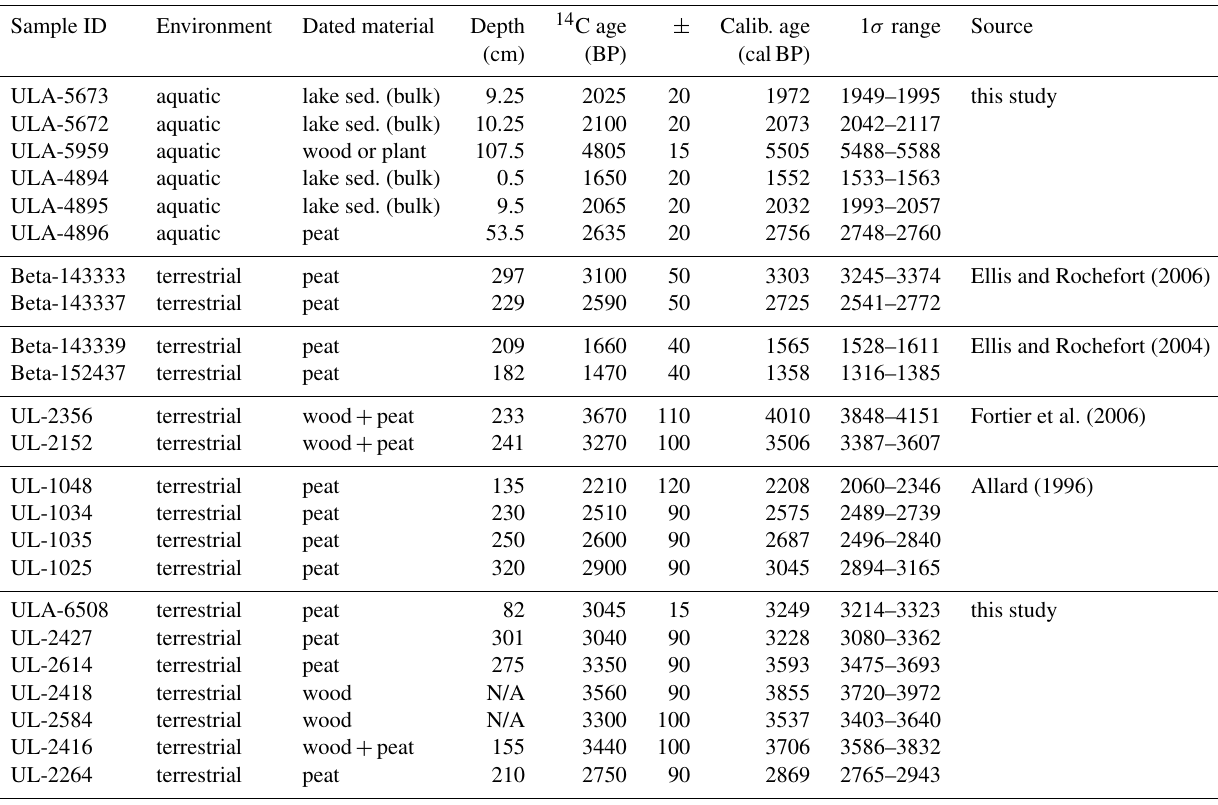
Table 1. Radiocarbon ( 14 C) dates obtained in sediment cores collected in Gull Lake and in soil samples collected in the surrounding frozen silt-peat terrace.